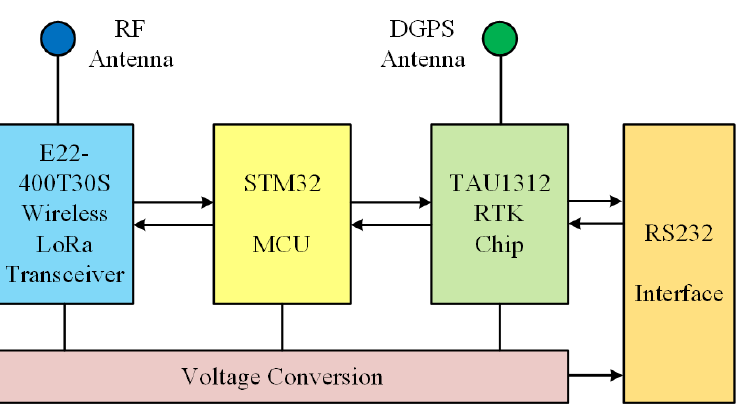
Figure 4. Self-made RTK